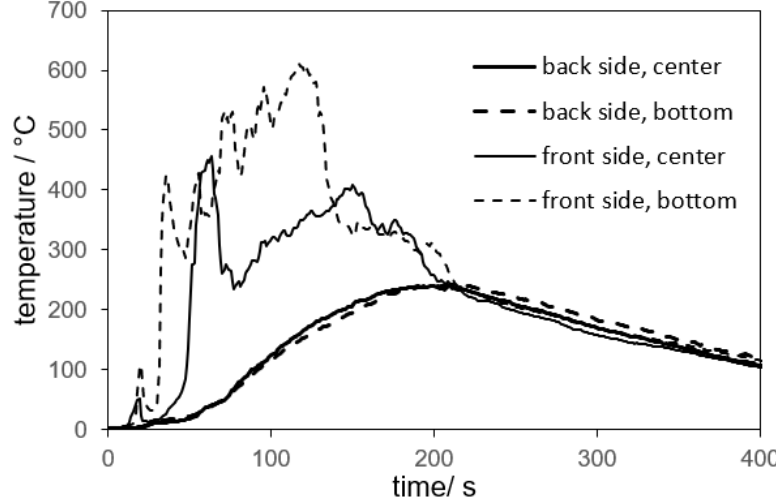
Figure 4. Temperature recordings for a large-scale IID fire test with a 4 mm thick horizontally aligned M18-1/G939 panel (see line 3 in Table 1).